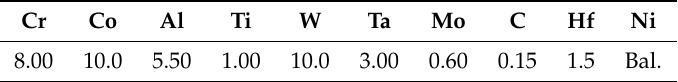
Table 1. Chemical composition of MAR-M247 (wt.%).